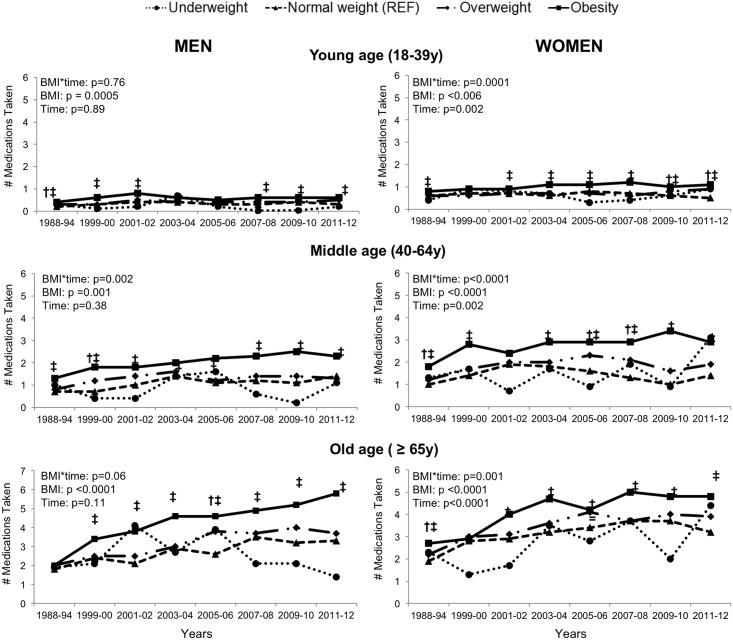
The number of prescription medications per BMI group over time in men and women by age category.BMI-related differences in prescription medication use were more apparent in older individuals and were magnified over time (age*BMI*time: P<0.001). BMI*time interaction is significant for each group (young, middle, old) in men and women (p<0.05). Significantly different from normal weight at that time point (* = underweight, † = overweight, ‡ = obesity; p<0.05). Mean values for the individual survey years were weighted and adjusted for ethnicity and education.